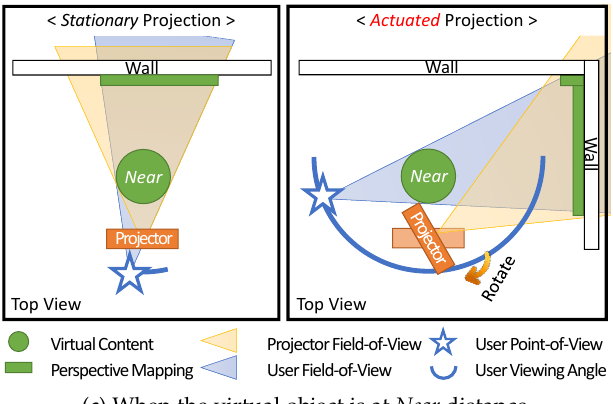
Figure 10. Changes in the viewing angle of the virtual object of varying distances, depending on the stationary or actuated projection conditions. In stationary perspective projection, the user’s viewing angle gradually diminishes as the virtual object is placed close to the user. However, in actuated perspective projection, the projector can rotate to widen the viewing angle, to the extent of the pan-tilt servos’ rotation bounds. For visibility, the front and rear cameras are